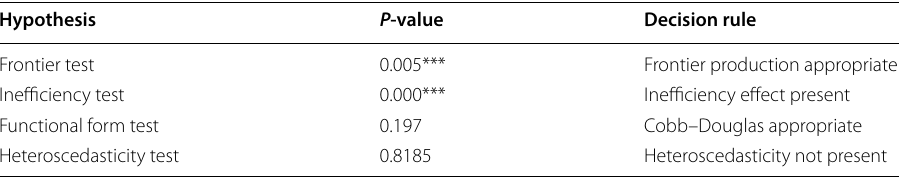
Table 2 Test of null hypothesis